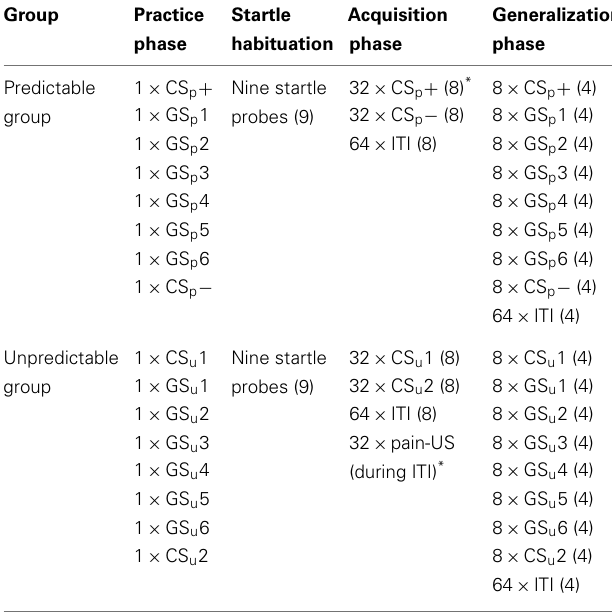
Table 1 | Experimental